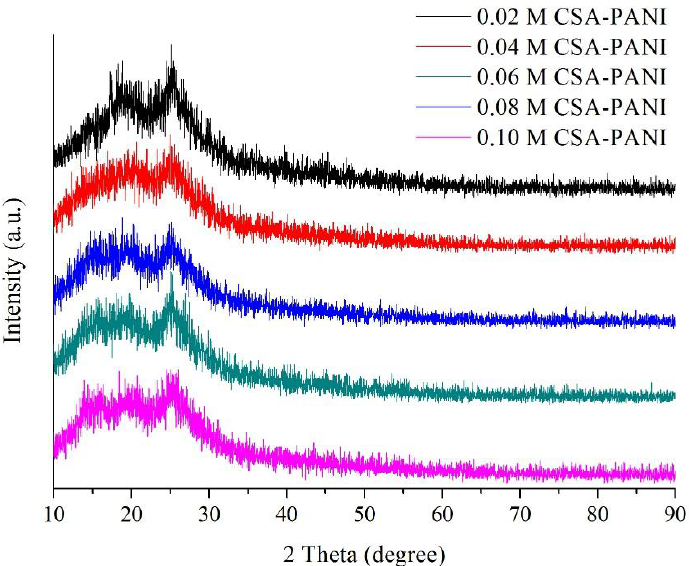
Figure 4. X-ray diffraction patterns of the prepared CSA-PANI nanopowders.